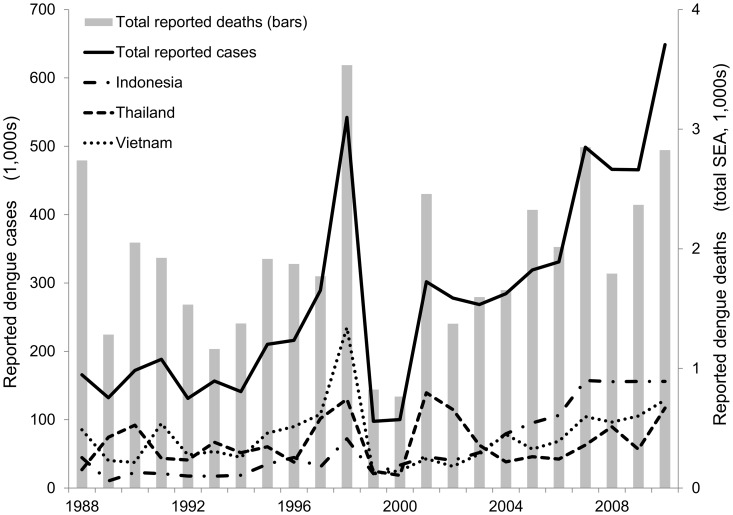
reported dengue episodes in Southeast Asia, 1988–2010.Sources: [11], [13], [29]–[33], [35]–[37].